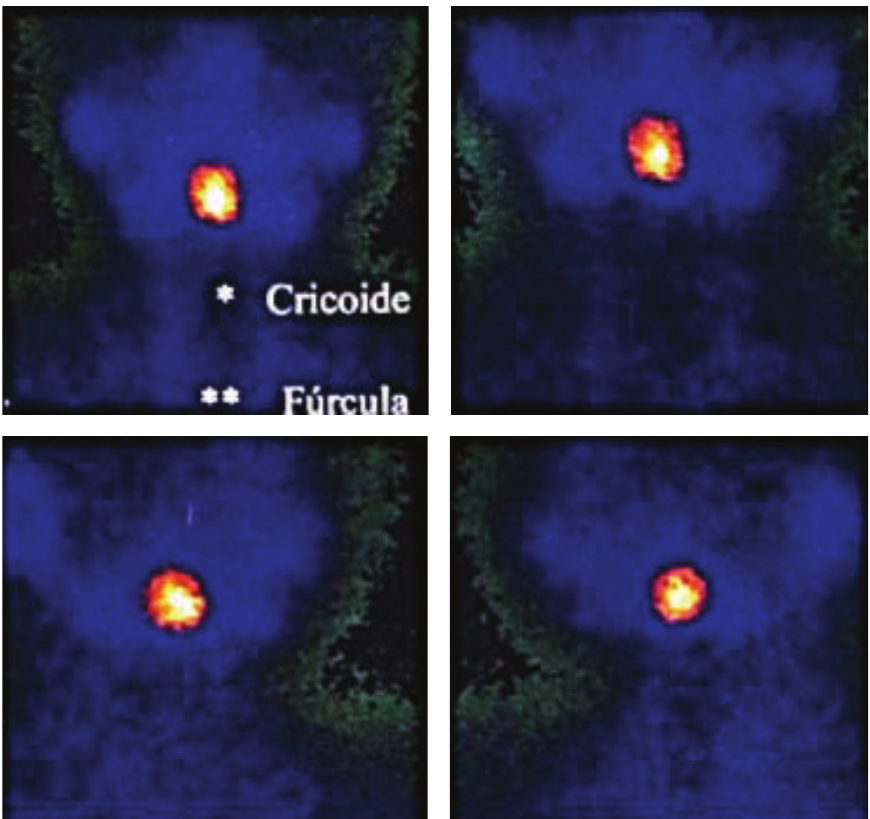
Figure 1: Scintigraphy—left side of neck. The quantification of radiopharmaceutical uptake by this change lies within the normal range of thyroid uptake.